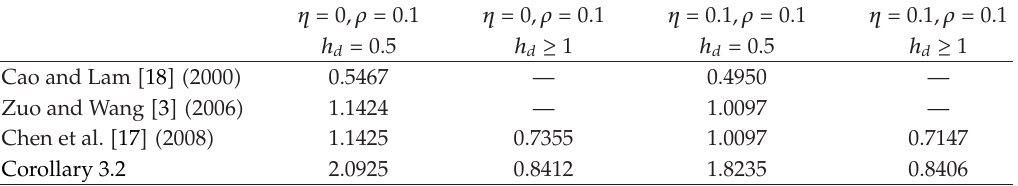
Table 1: Upper bounds of time delays in Example 4.2 for various conditions.